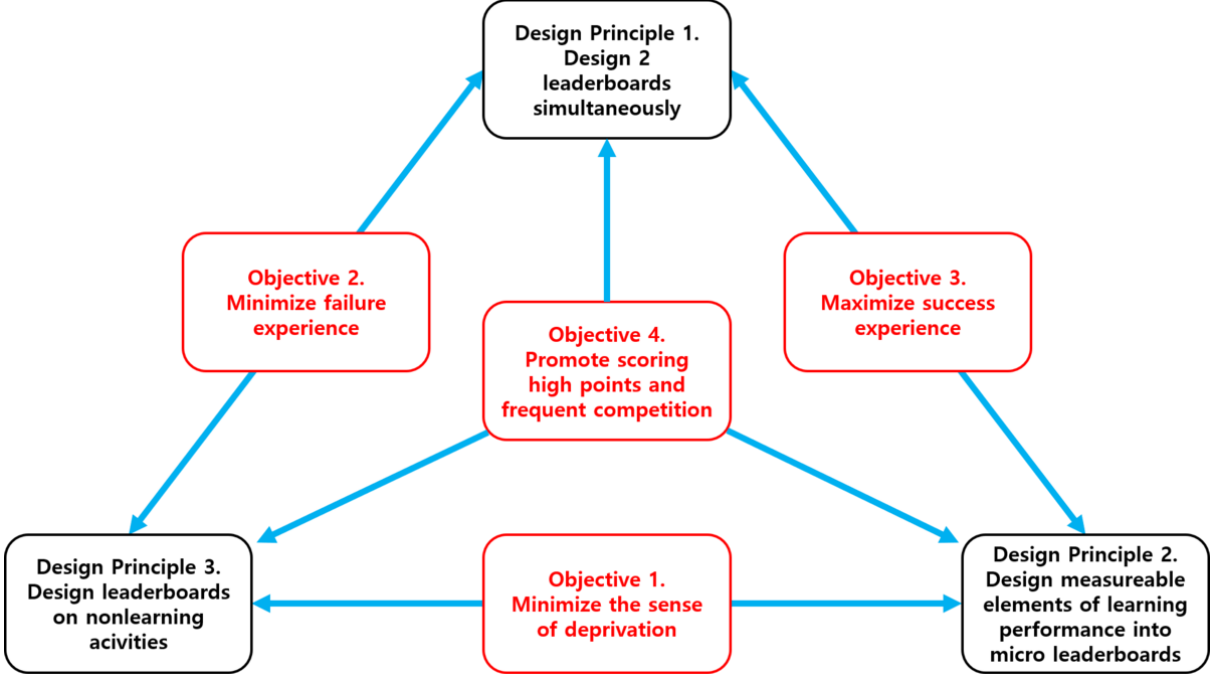
Figure 4. Suggested structure for leaderboard